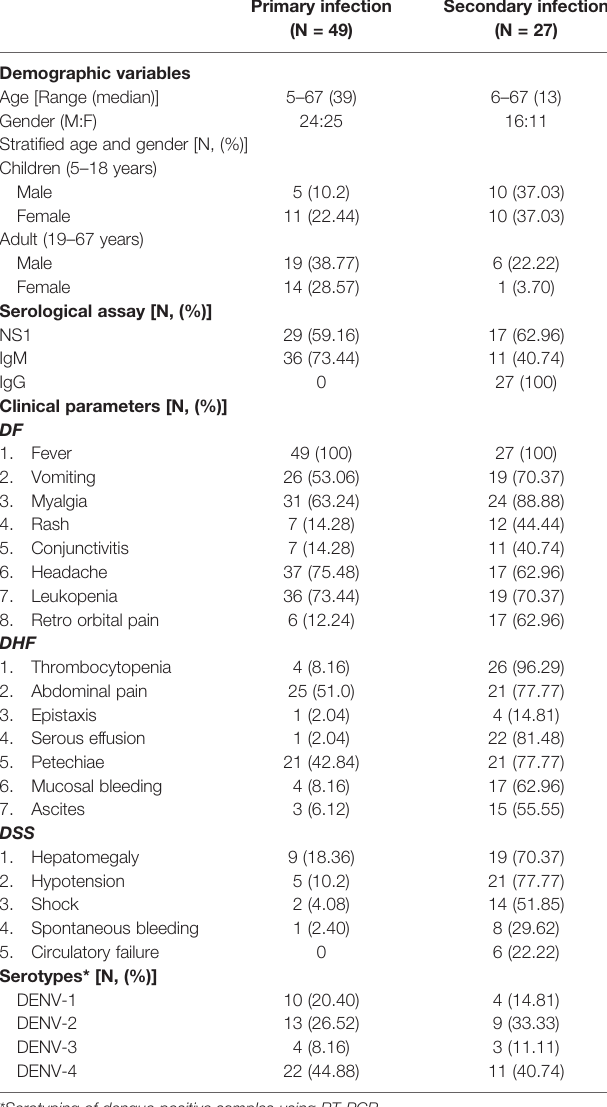
TABLE 1 | Demographic variables, serology, clinical presentations, and serotypes observed in DENV infection. Primary infection (N =